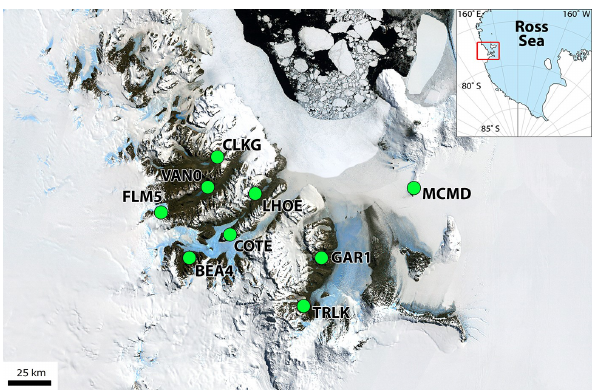
Figure 1. Landsat image mosaic of Antarctica, LIMA (Bind- schadler et al., 2008), map of the central McMurdo Dry Valleys with locations of UNAVCO fixed Global Positioning System ground sta-